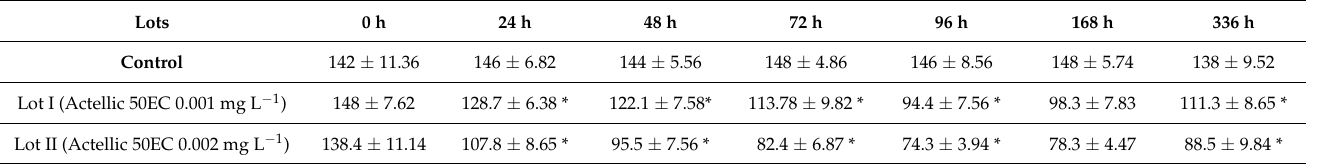
Table 6. Variations in the average oxygen consumption (mL of oxygen/kilogram/hour) and the stan- dard deviation of the Prussian carp exposed to Actellic 50 EC insecticide at different